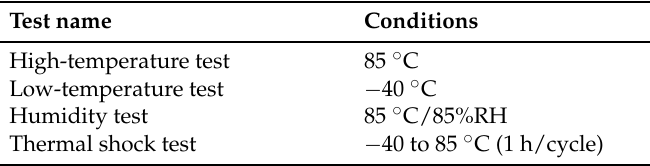
Table 6. Reliability test conditions.